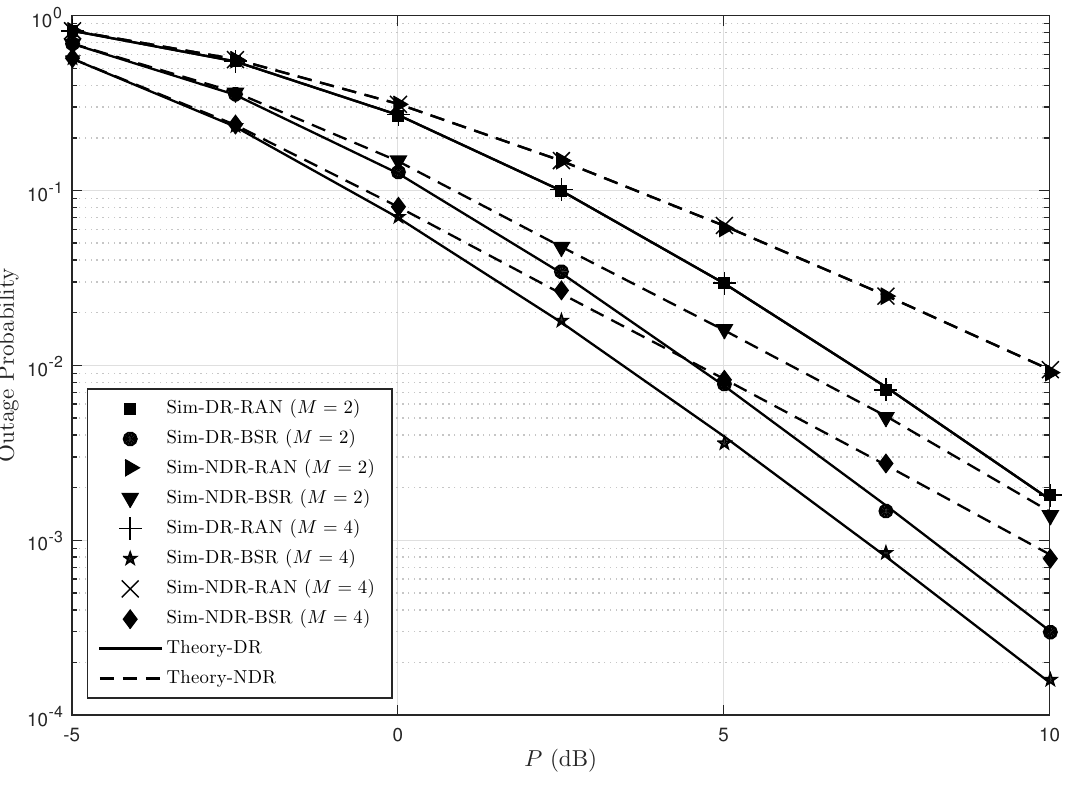
Figure 2. Outage probability versus transmit power P in dB for the four protocols and for M of 2 and 4 with ( x ( x R 2 , y R 2 ) = (0 . 5 , − 0 . 3) , ψ t = 1 bit/s/Hz, ρ = 0 . 5 , η = 0 . 5 , and N = 2